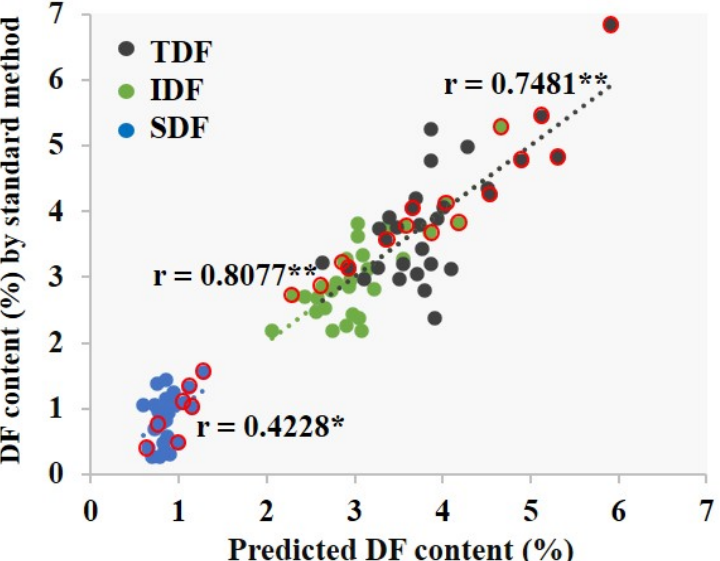
Figure 2. Linear regression between soluble dietary fibre (SDF), insoluble dietary fibre (IDF), and total dietary fibre (TDF); predicted value from the alkaline method and determined value from the standard method. Rice varieties with ASV equal to exactly 1 are shown as circles with a red border. * Correlation is significant at the 0.05 level. ** Correlation is significant at the 0.01 level.